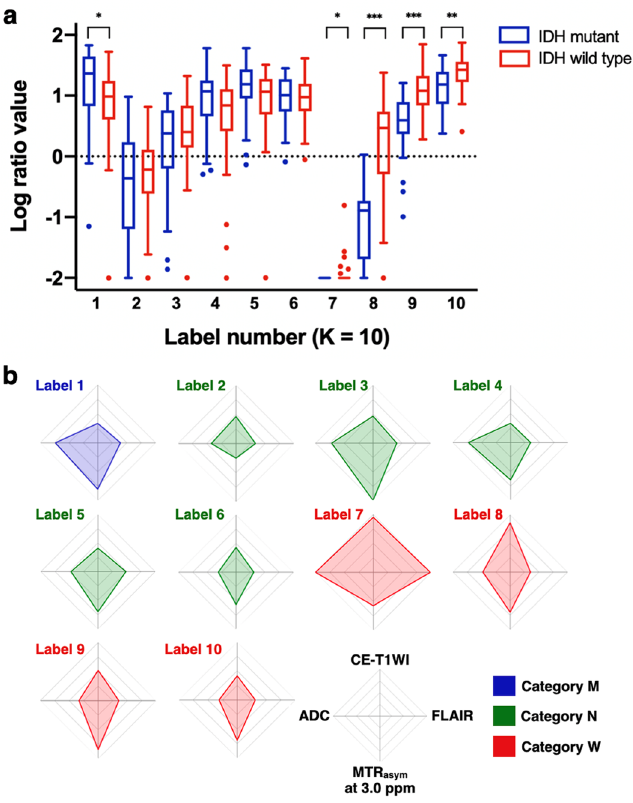
Figure 2. ( a ) Box-whisker plots and ( b ) radar charts of labels by 10-class clustering. ( a ) The box shows the interquartile range between the 25th and 75th percentiles for log-ratio values; the lines within the boxes represent medians, and the whiskers represent measurements 1.5 times the interquartile range. The circles represent outliers beyond 1.5 times the interquartile range. * P < 0.05, ** P < 0.01, *** P < 0.001. ( b ) Radar charts of four variables (CE-T1WI, FLAIR, MTR asym at 3.0 ppm, and ADC) in each label categorized into three